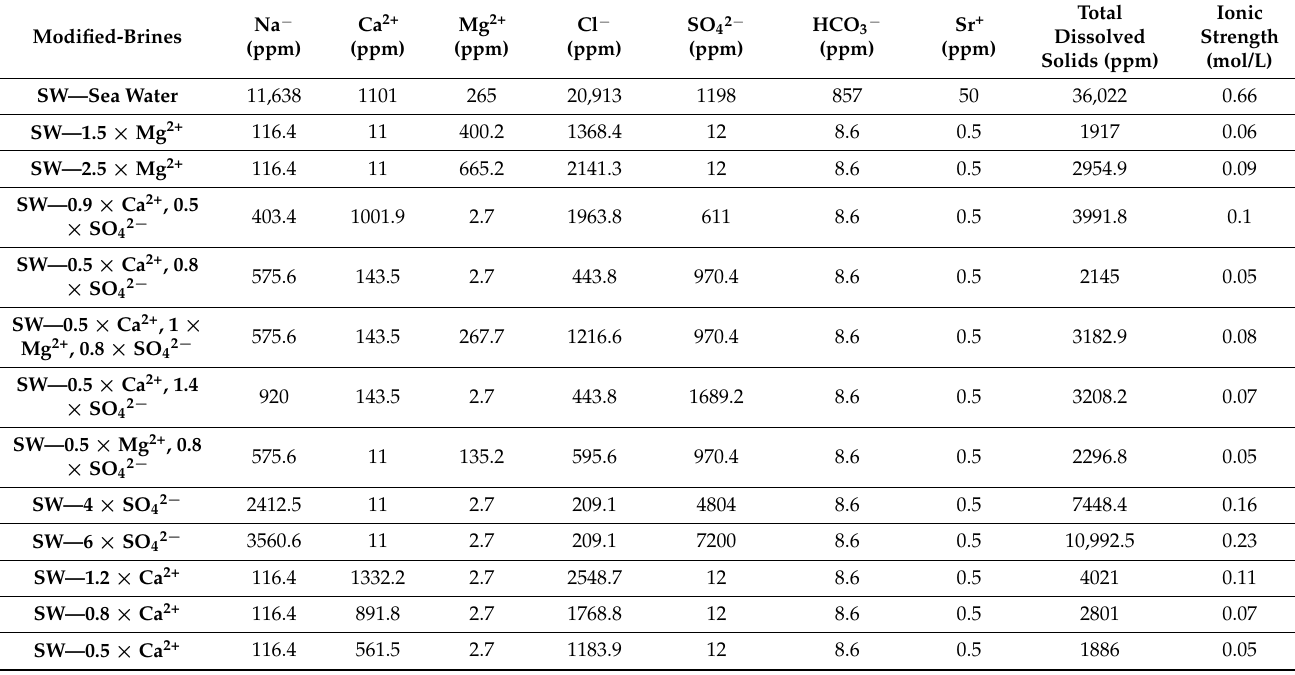
Table 2. Ionic concentrations, TDS, pH, and ionic strength of modified